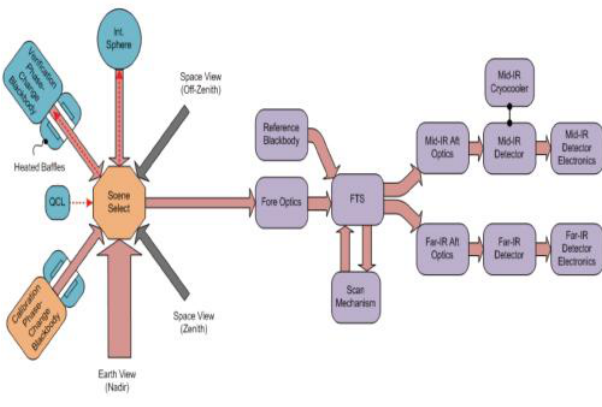
Figure 7. Optical functional diagram for the IR CLARREO instrument